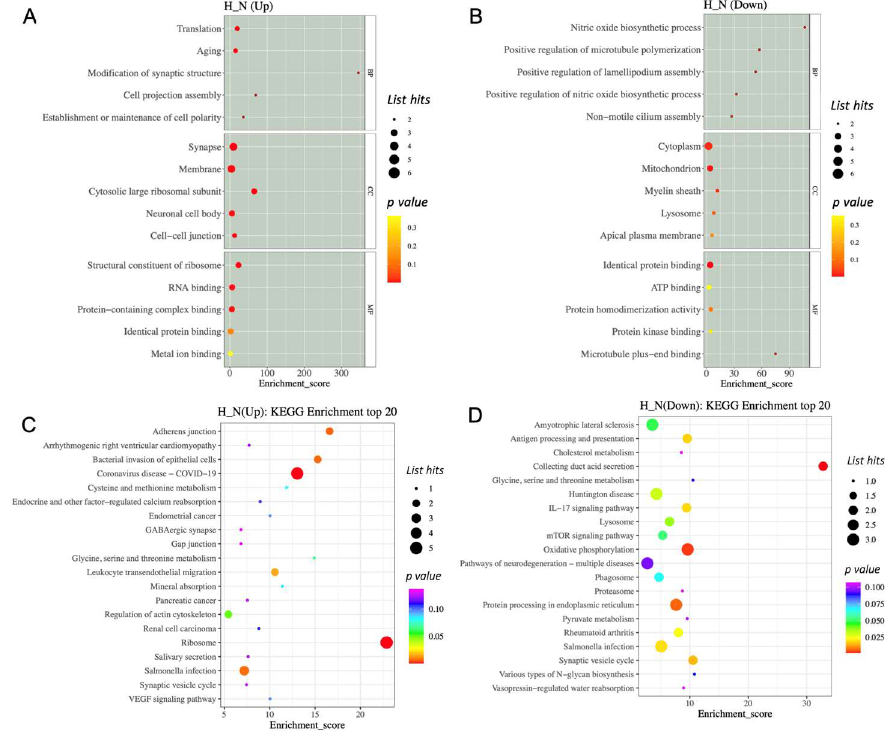
Figure 5. The GO and KEGG enrichment analysis of differentially expressed proteins. ( A , B ) GO enrichment analysis top 15 (screening the GO entries that correspond to the number of differential proteins greater than 1 in the three categories). ( C , D ) The KEGG enrichment analysis of differen- tially expressed